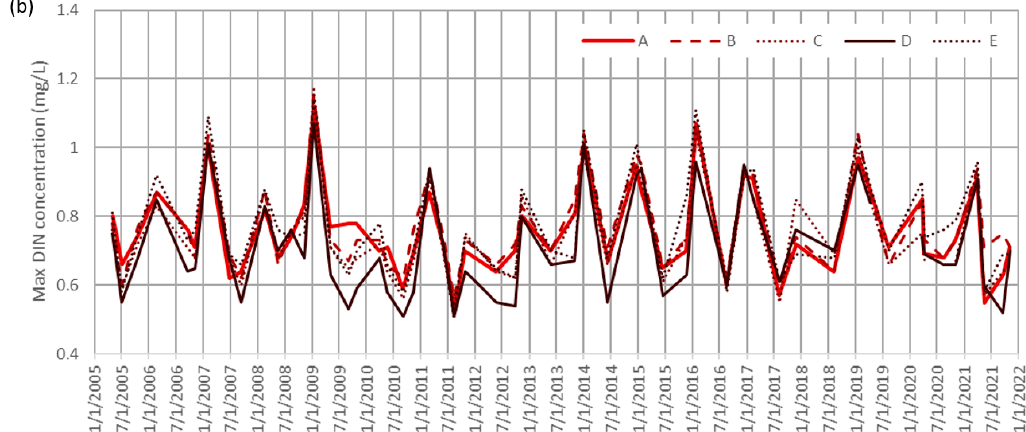
Figure 10. Seasonal variation of ( a ) mean and ( b ) maximum DIN concentration in the five oyster- growing areas (A–E in Figure 2).